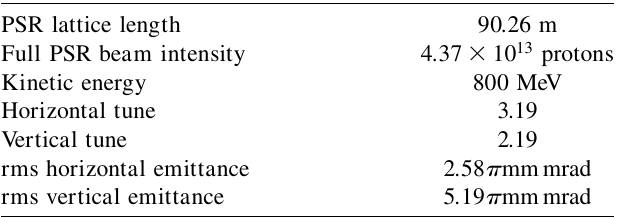
TABLE I. PSR parameters for a high intensity beam accu- mulation scenario. Emittances typical of the beam halfway through the accumulation.